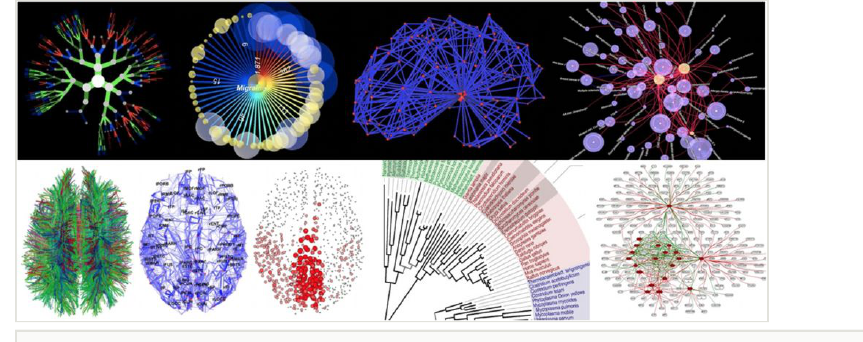
Examples of graph-based representations of scienti fi c data among hundreds on the www.visu alcomplexity.com website (categories on the site include biology, food webs and semantic, social, and knowledge networks). Lower left images of DTI, connectome, and network hubs are from Olaf Sporns (2010, Scholarpedia,